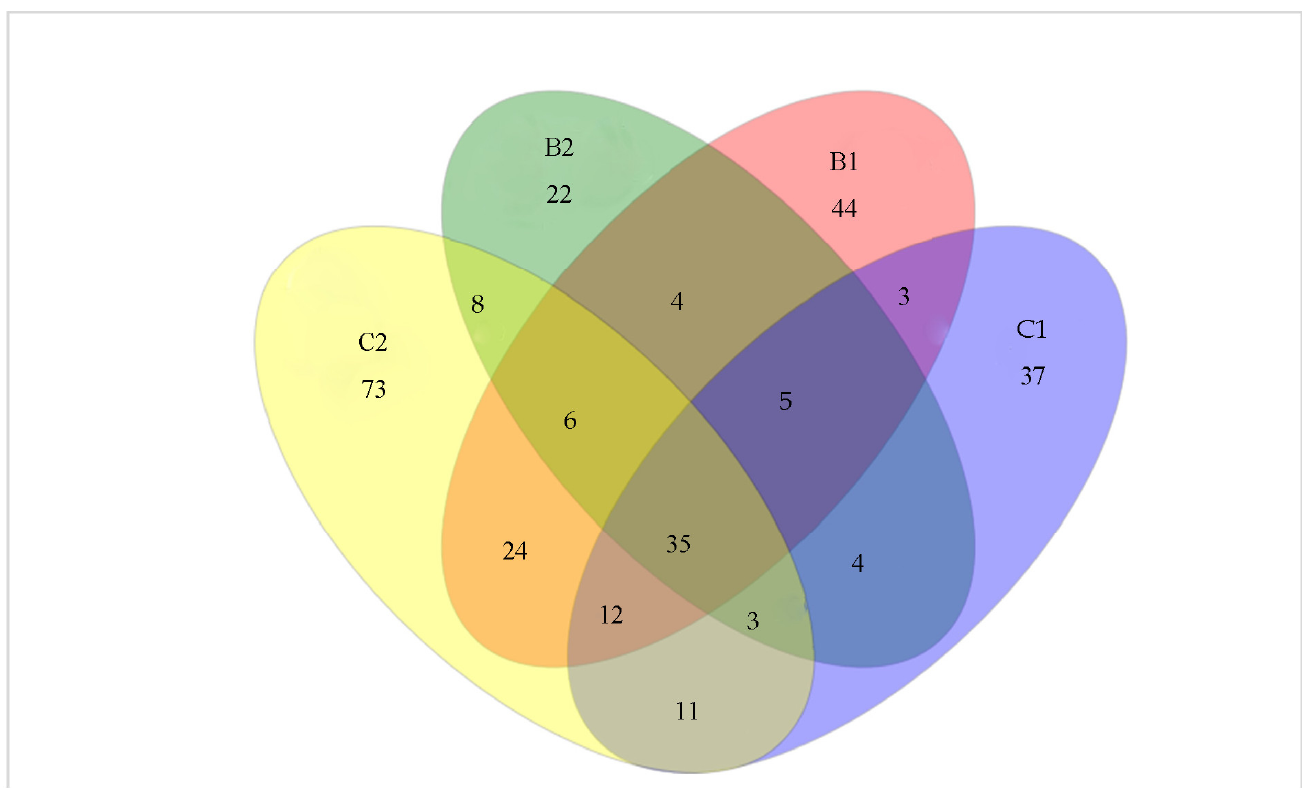
Figure 1. A Venn diagram of shared and unique OTUs of epiphytic bacterial communities of lettuce plants grown in Bacillus probiotic treated and control systems. B1 and B2 represent leaf samples obtained from Bacillus probiotic supplemented systems and C1 and C2 represent leaf samples from the control systems .